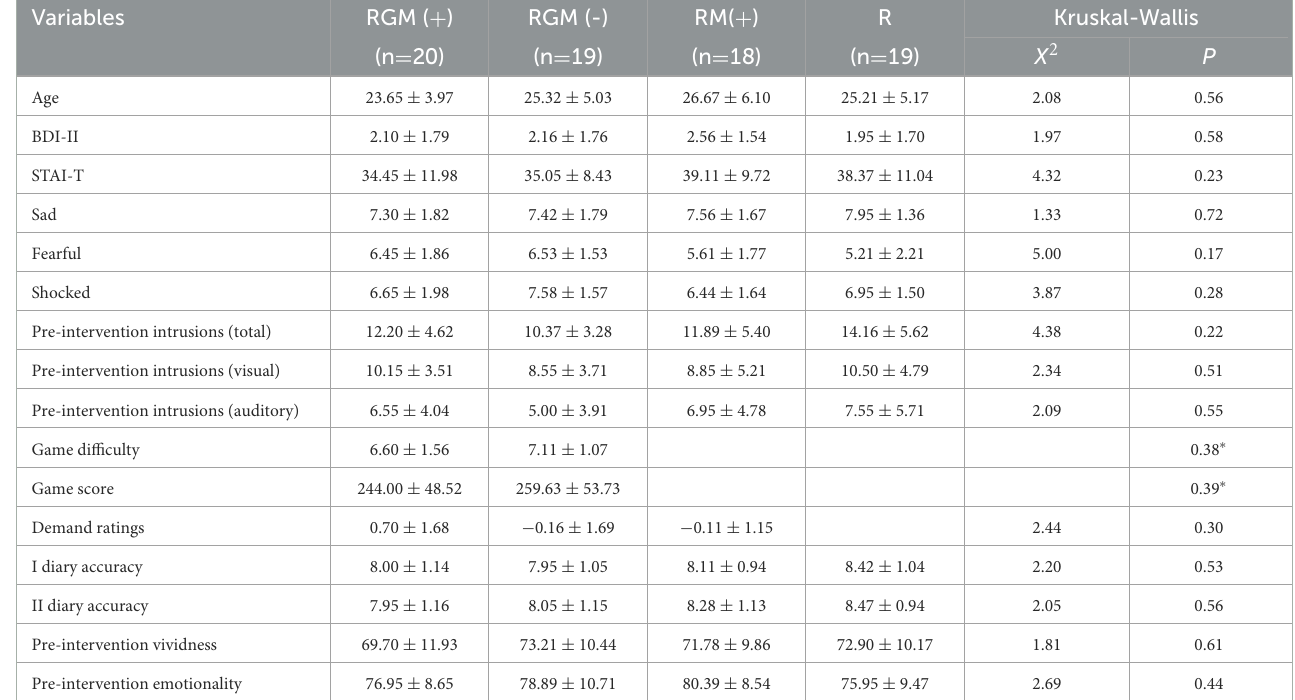
TABLE 1 Baseline characteristics (variables were presented as mean ±